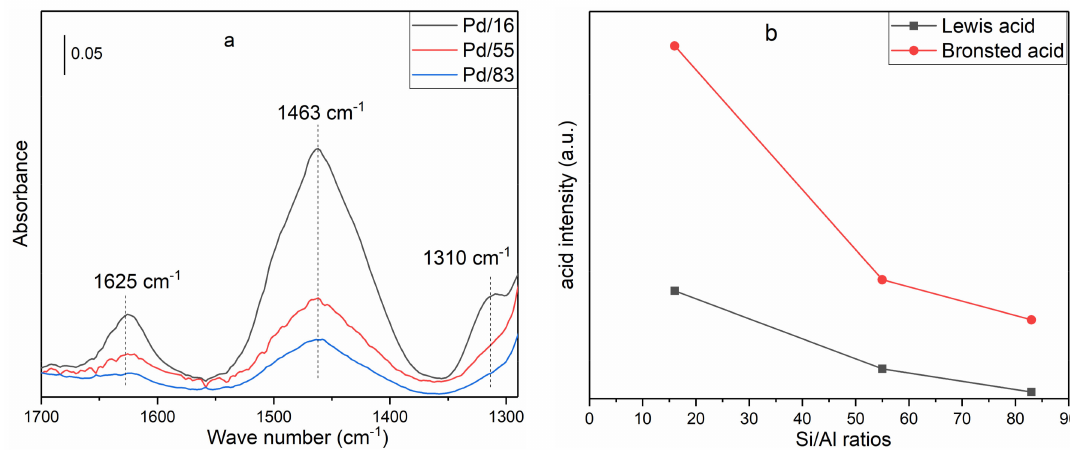
Figure 7. ( a ) In situ FT-IR of NH 3 adsorption (temperature: 80 ◦ C; flow: NH 3 (500 ppm) + N 2 ). ( b ) The acid intensity as a function of the Si/Al ratio.